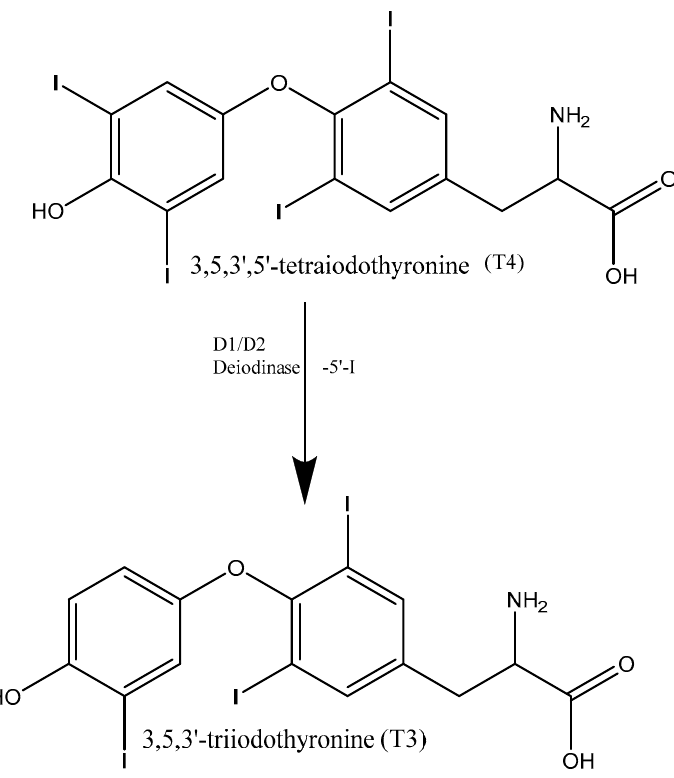
Figure 1. Conversion of T4 to T3 by deiodination.